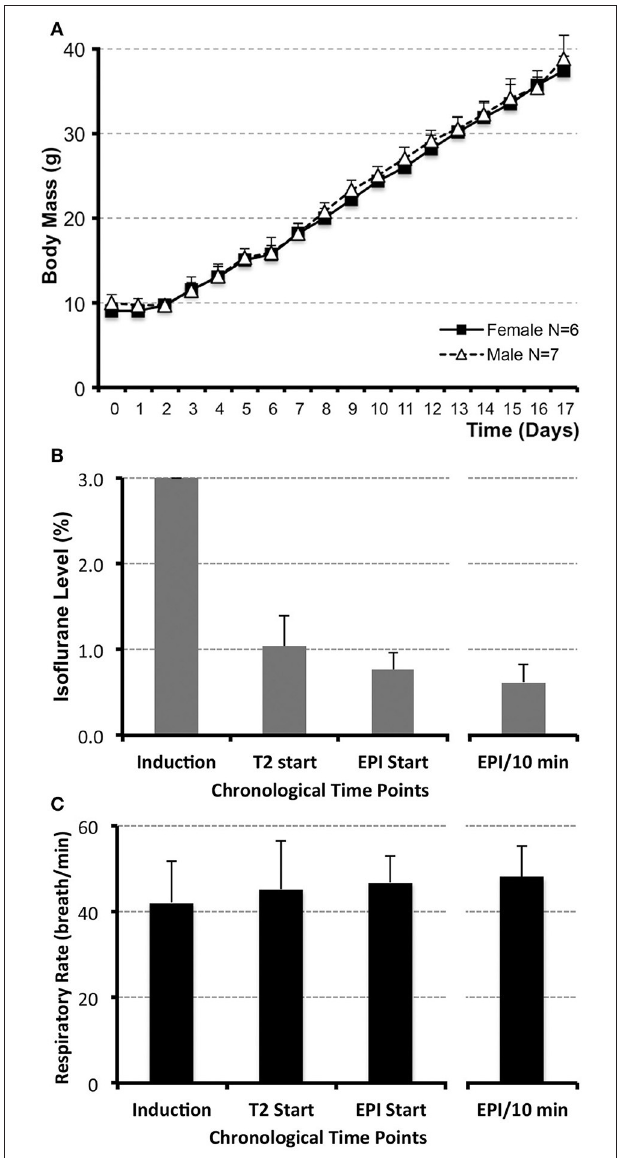
FIGURE 1 | Infant rat growth (A) and anesthesia management during MRI (B,C). (A) illustrates the average weight of infant rats ( N = 13; g ± SD ) from postnatal day (PD) 0, considered the day of birth, through PD17 for both female ( N = 6) and male ( N = 7) rats. No significant differences between sexes were observed at any of the time points. (B) illustrates average levels of administered inhalational anesthetic, Isoflurane/O 2 at 1 L/min via nose cone (% ± SD ; N = 13), at different time points during the scanning. Following uniform induction with 3% Isoflurane/O 2 at 1L/min, anesthetic level was decreased to maintain a consistent respiratory rate in a narrow range between 45 and 50 breaths/min (C) . Analysis included the values at the start of the first (anatomical RARE) scan, as well as the start of the second (functional EPI) scan. Average value of Isoflurane level during the length of the functional scan (based on the two 5min interval measurements/animal) and its average corresponding respiratory rate are shown in the far-right columns (B,C) . Respiratory rate was used as an indirect measure of steady and uniform anesthetic depth during functional scan. No differences in respiratory rate (breath/min ± SD ) were noted between different time points analyzed [ C ; induction, T2 start, EPI start, average EPI/10min; F (3 , 47) = 1.11, p = 0.35]. One-way ANOVA with Tukey HSD